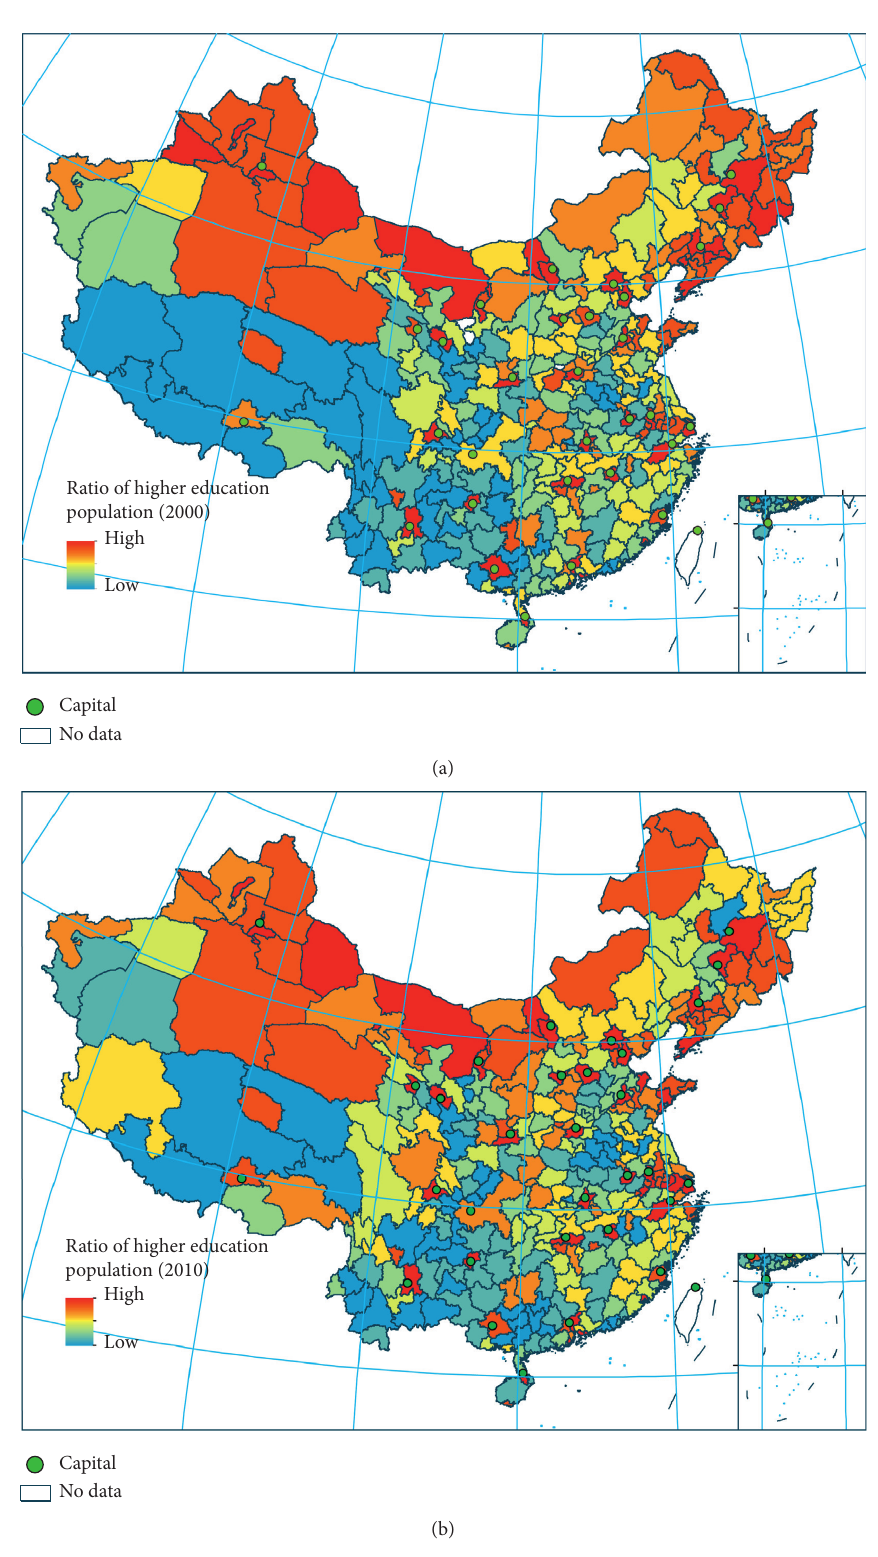
Figure 6: HEP ratios: (a) HEP ratio in 2000 and (b) HEP ratio in